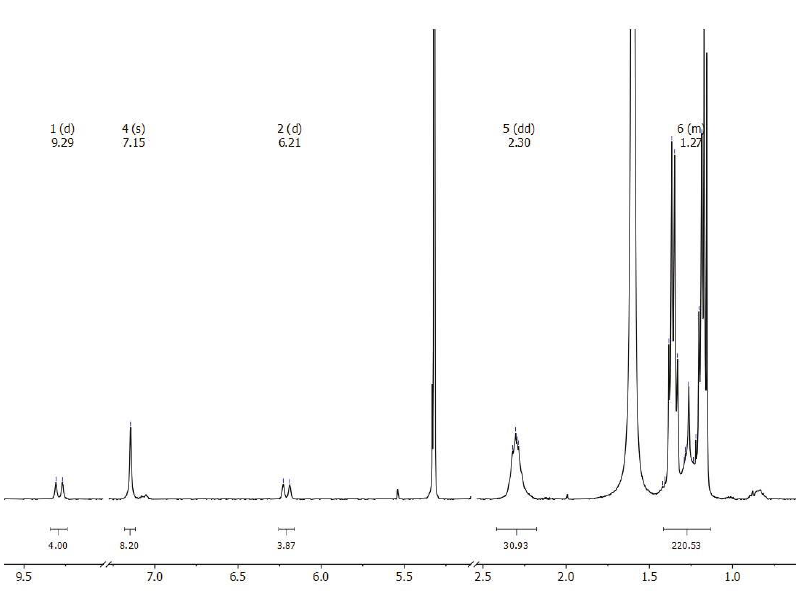
Figure 4. 1 H-NMR spectrum of 2 Ru 2 Ph-Croc in CD 2 Cl 2 . Slow diffusion of methanol into a dichloromethane solution containing 2 Ru 2 Ph-Croc